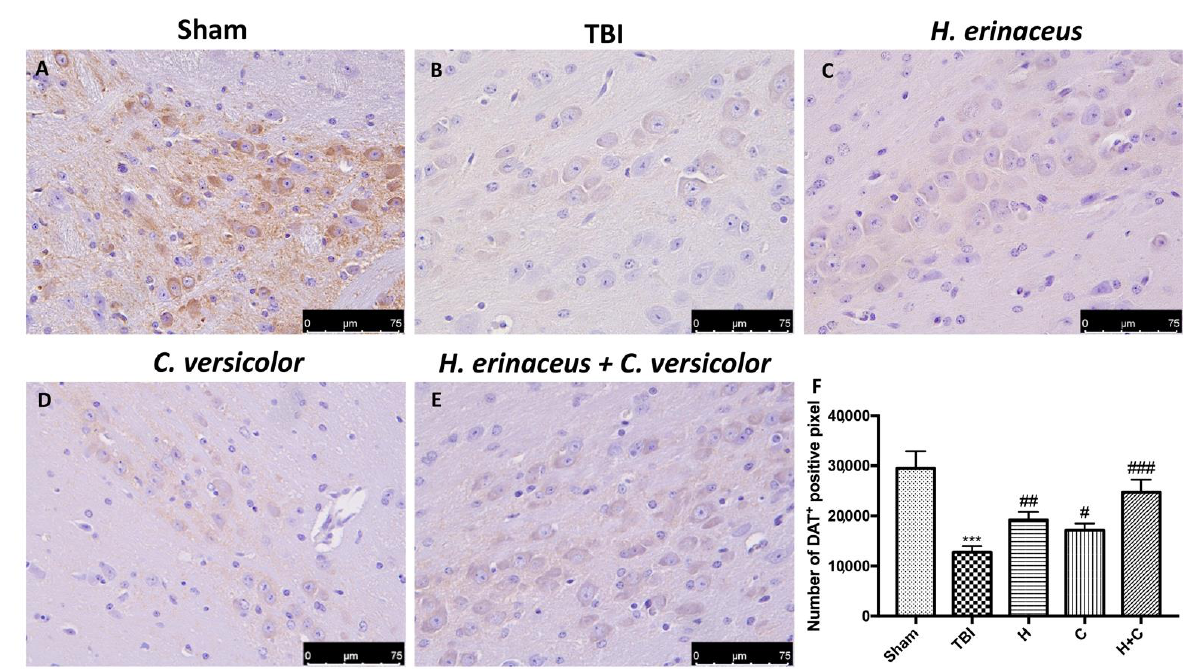
Figure 13. Effect of H. erinaceus or C. versicolor , or H. erinaceus + C. versicolor treatment on DAT expression after chronic TBI. Immunohistochemical analysis on midbrain region showed a significant loss of DAT-positive cells ( B ) compared to Sham mice ( A ). Animals treated with H, C and especially with H + C revealed an increase in the expression of DAT ( C – E ). Data is expressed as % DAT-positive pixels and are the SEM means of n = 5 mice/group. ( F ) *** p < 0.001 vs. Sham; ## p < 0.01 vs. TBI; # p < 0.05 vs. TBI; ### p < 0.001 vs. TBI.